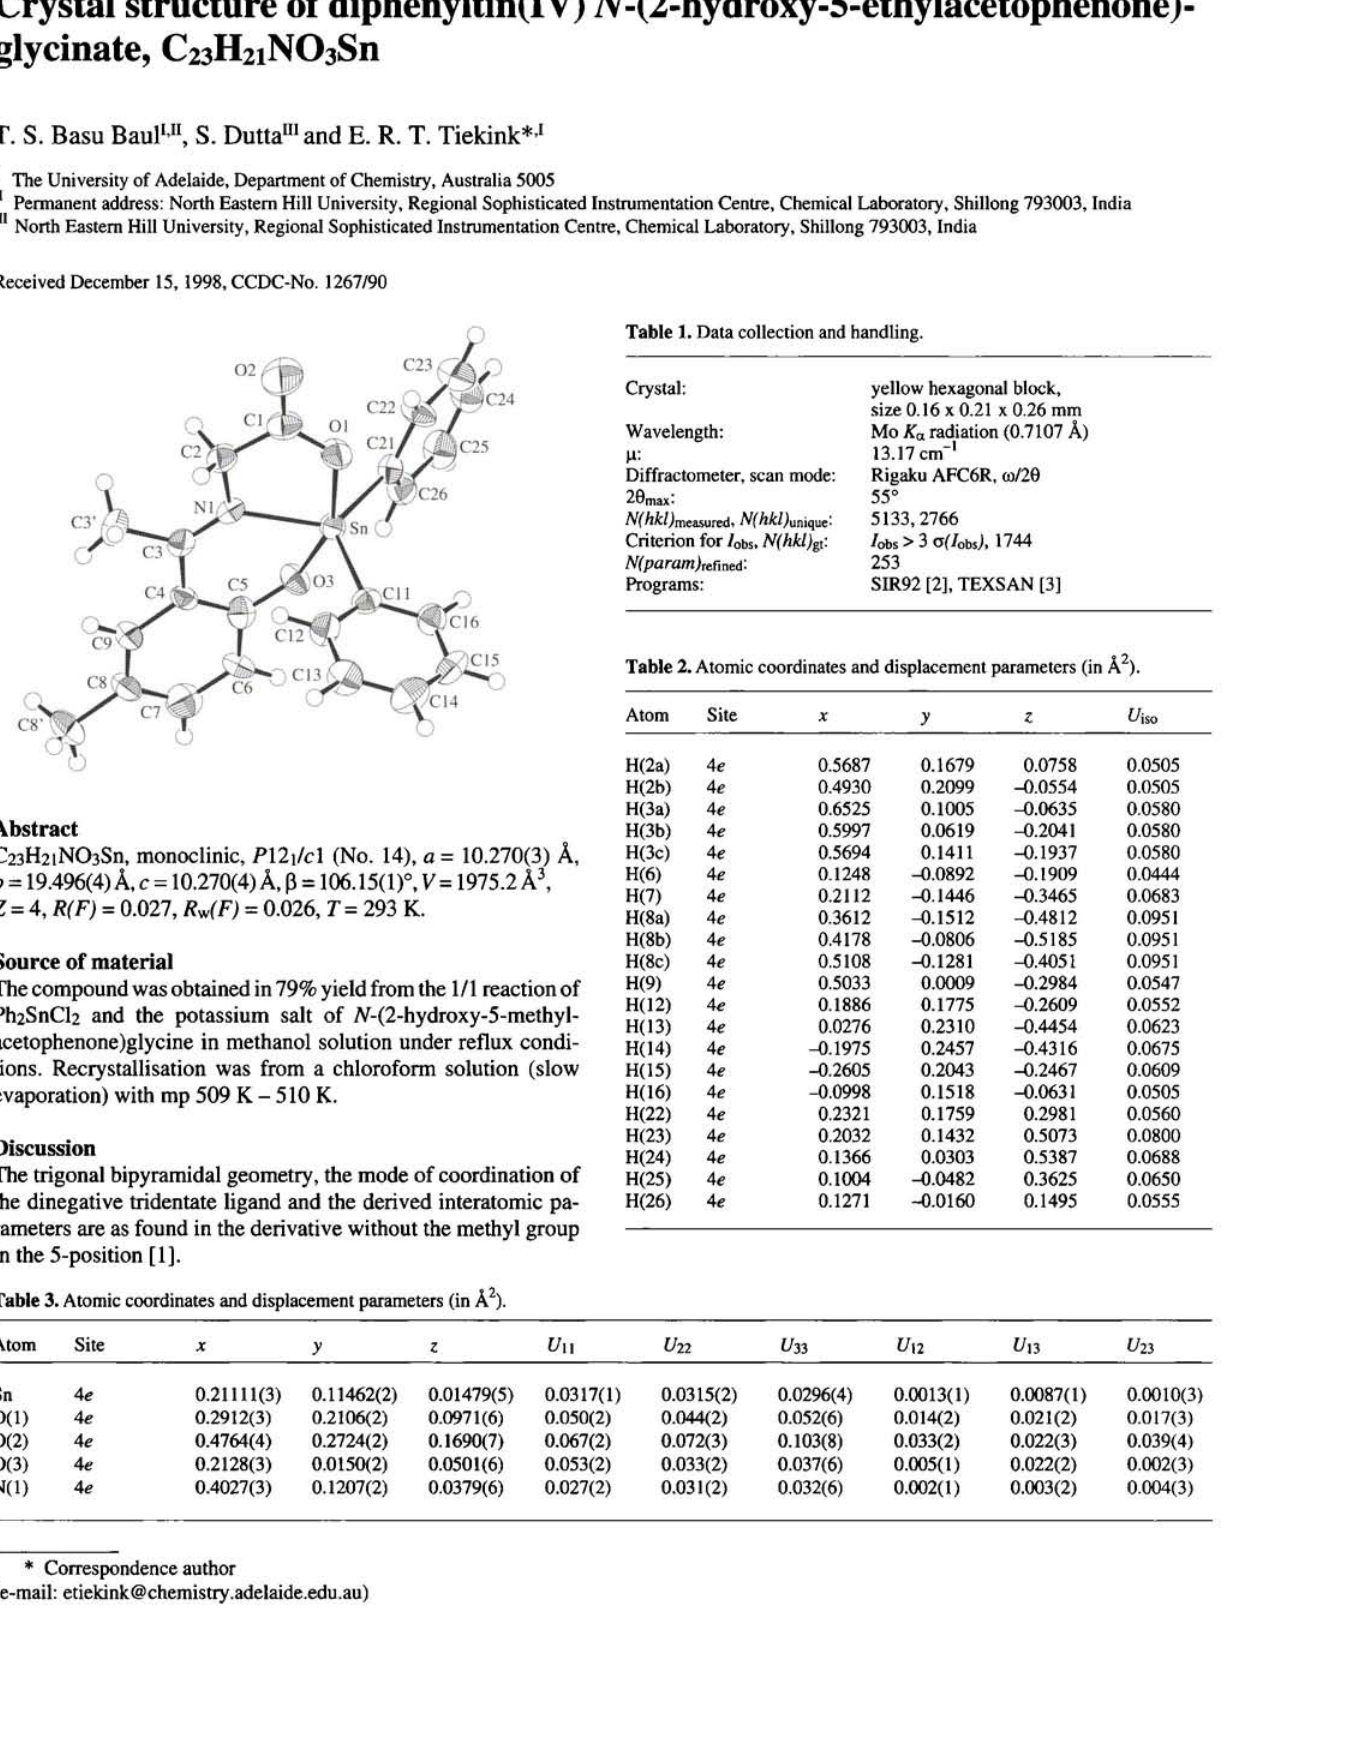
Table 3. Atomic coordinates and displacement parameters (in Â 2 ).